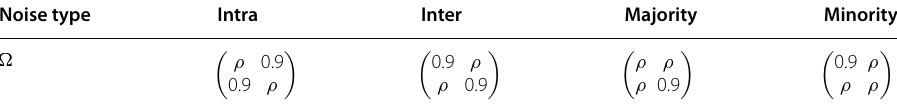
We model four different noise types. We use the retain parameter ρ to control the noise probability of edges. For inter-group noise, e.g., we retain an edge that connects the two classes with probability ρ , while we retain edges within a class with 90% probability